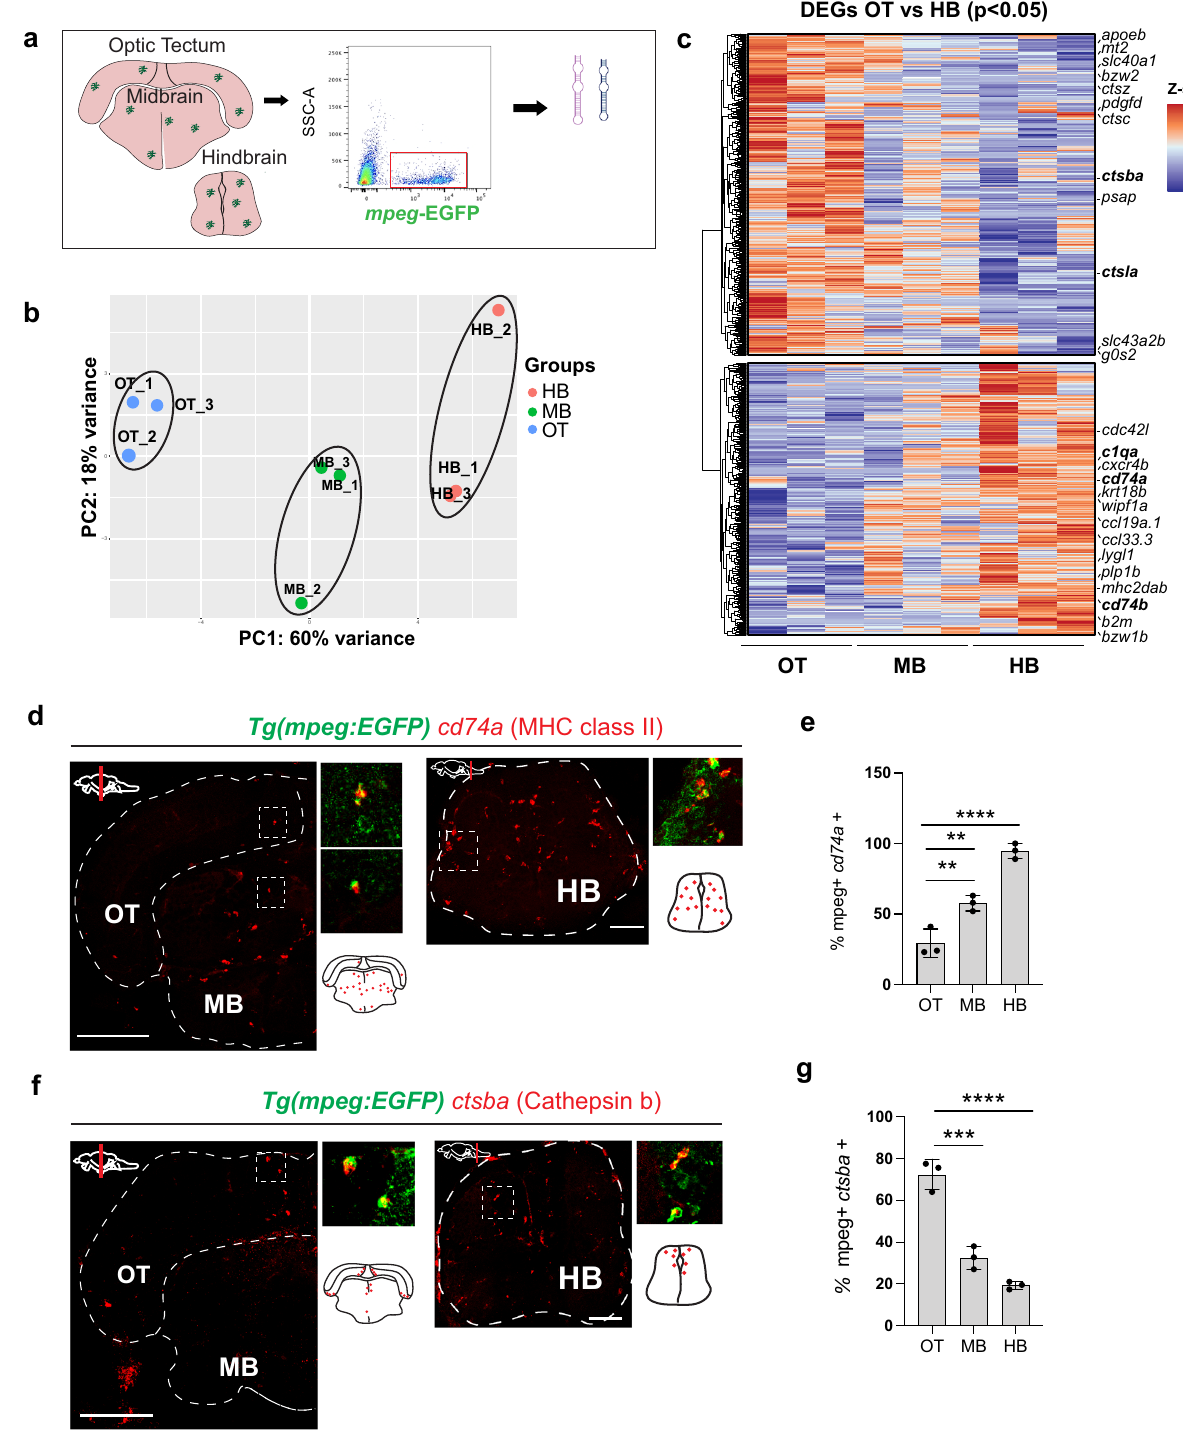
Fig. 3 Region-speci fi c transcriptional signatures of juvenile zebra fi sh myeloid cells. a Schematic of region-speci fi c bulk-sequencing approach